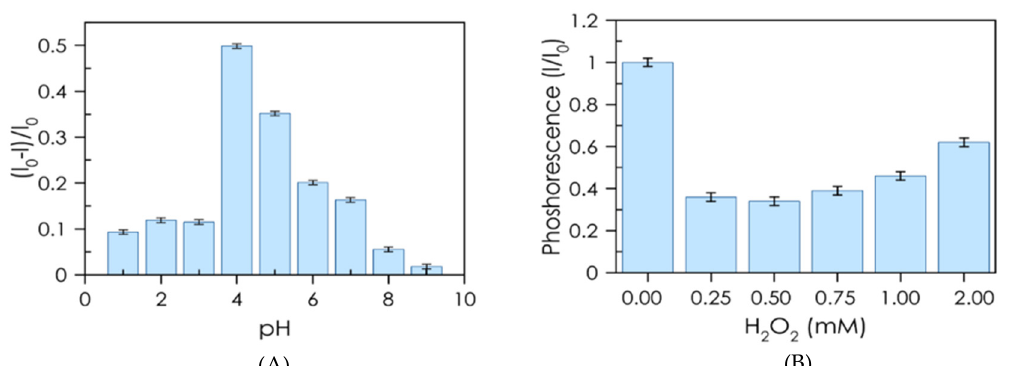
Figure 5. ( A ) pH dependence of luminescence quenching; 2.8 × 10 − 3 mg·mL − 1 CDs, 0.5 mM H 2 O 2 , 1 μ M Hb in 0.02 M phosphate buffers. ( B ) Influence of H 2 O 2 concentration on luminescence quenching; 2.8 × 10 − 3 mg·mL − 1 CDs, 0.15 μ M Hb in 0.02 M NaH 2 PO 4 /Na 2 HPO 4 pH = 4.7 buffer.